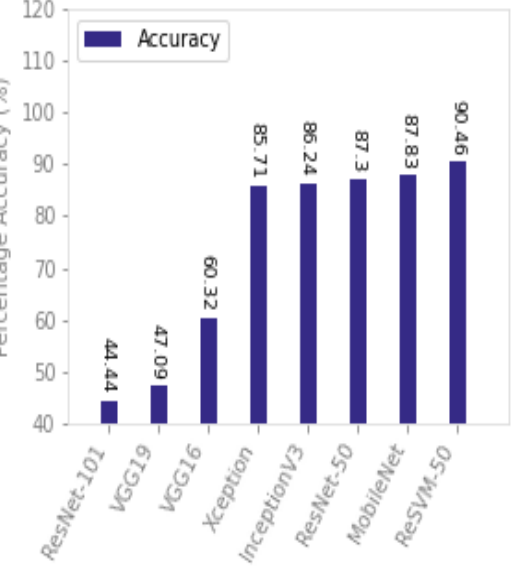
Figure 9. Comparison of ReSVM with existing state-of-the-art approaches in terms of percentage accuracy on BU